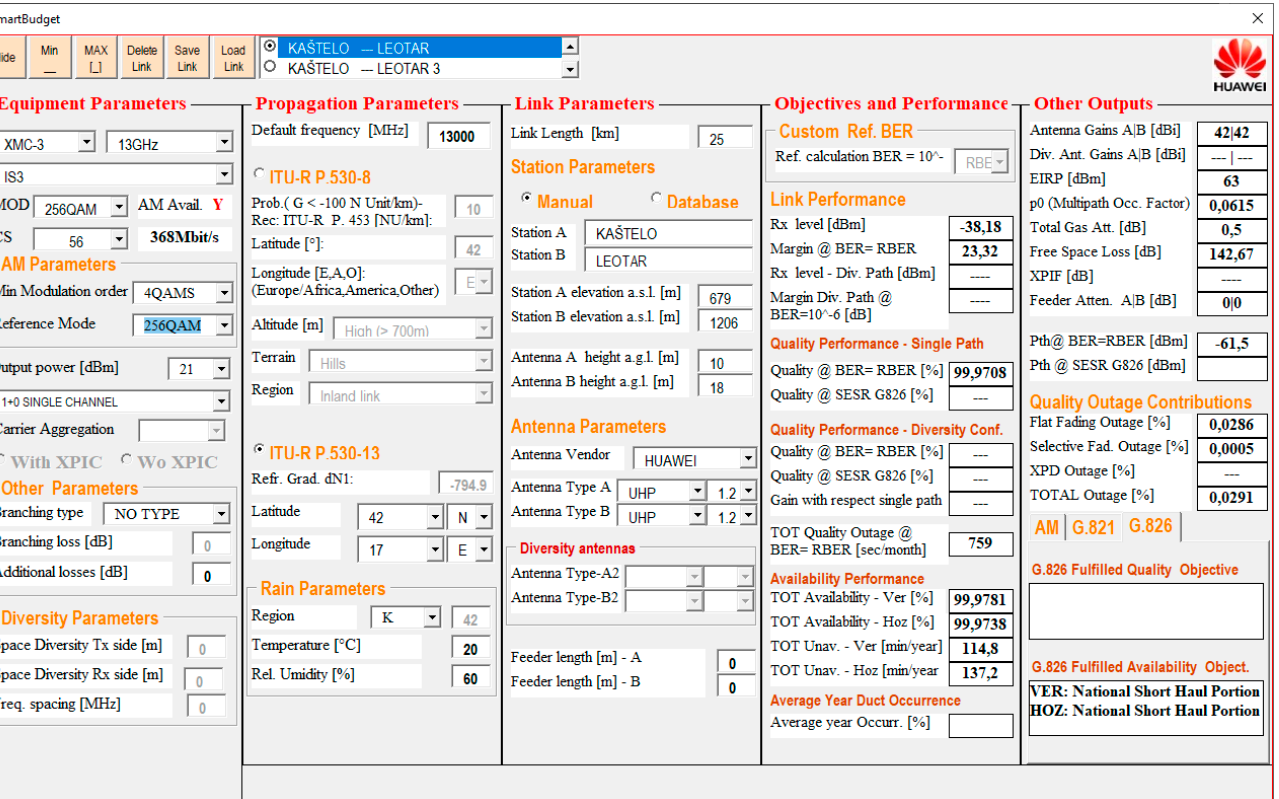
Figure 14. Prediction for the fourth RR section; 2048 QAM, 500 Mb/s.